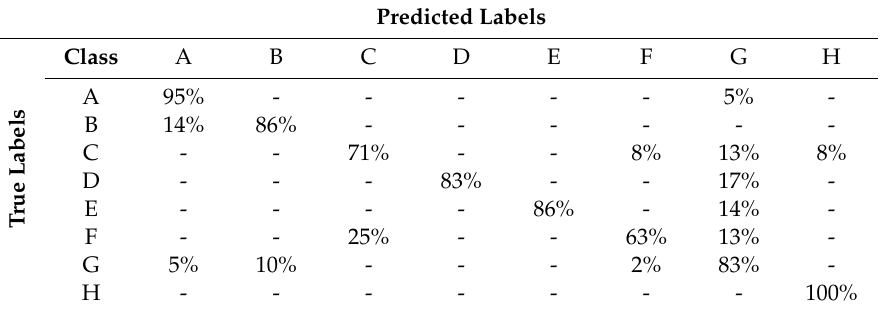
Table 7. Confusion matrix for the model of category prediction (M C ).